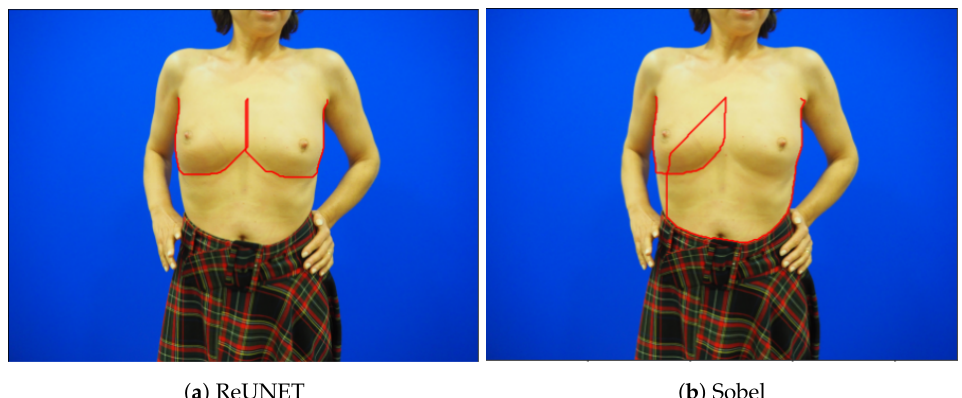
Figure 10. Predicted keypoints for shortest-path algorithm using SobelU-NET ( a ) and Sobel ( b ) on the BCCT core